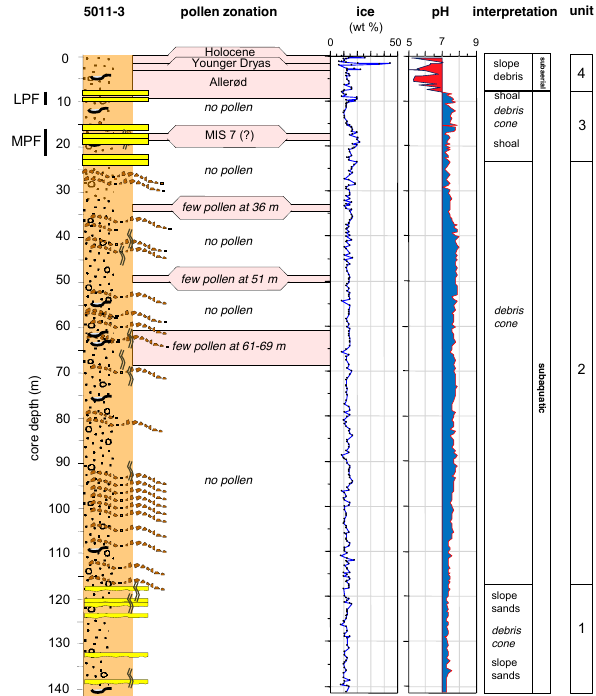
Fig. 7. The lithological log of core 5011-3 with pollen zones (partly shown as stratigraphic zones; MIS=marine isotope stage), ground ice properties (ice content and pH), and depositional interpretation. LPF = Late Pleistocene flooding event; MPF = Middle Pleistocene flooding event.